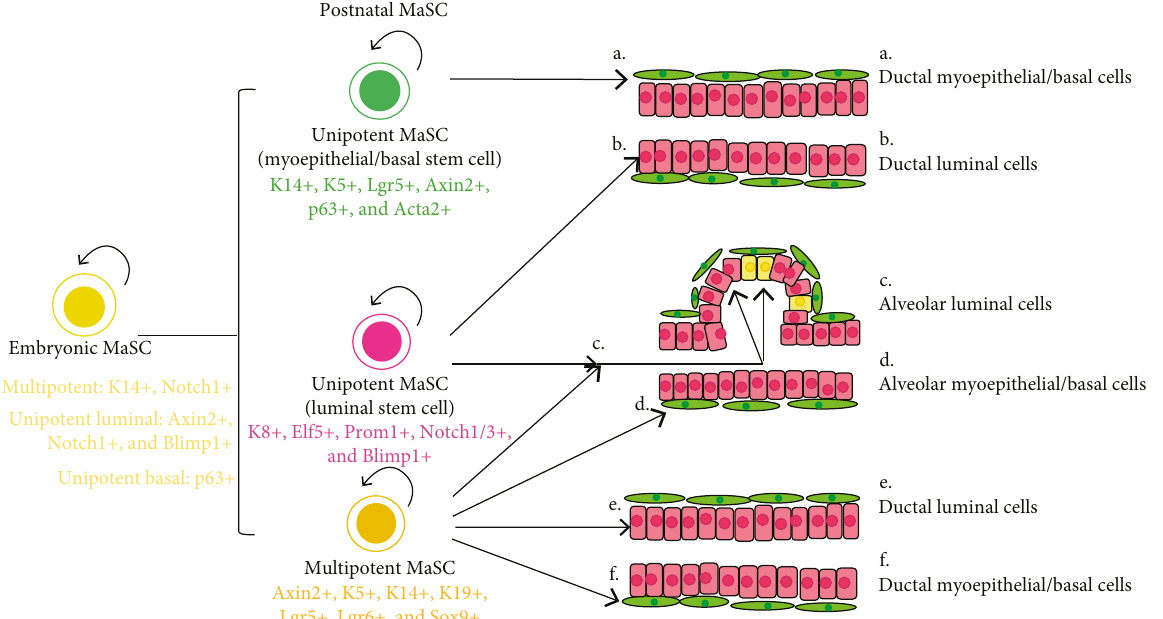
Figure 2: Cellular fate mapping of MaSCs by lineage tracing in vivo . A simpli fi ed schematic depicts the existence of unipotent and multipotent MaSCs characterized with distinct cellular markers (embryonic MaSCs: K14+, Axin2+, Notch1, Blimp1+, and p63+; postnatal MaSCs for unipotent basal lineage: K14+, K5+, Lgr5+, Axin2+, p63+, and Acta2+; postnatal MaSCs for unipotent luminal lineage: K8+, Elf5, Prom1+, Notch1+, Notch3+, and Blimp1+; multipotent postnatal MaSCs: Axin2+, K5+, K14+, K19+, Lgr5+, Lgr6+, and Sox9+) and their distinct di ff